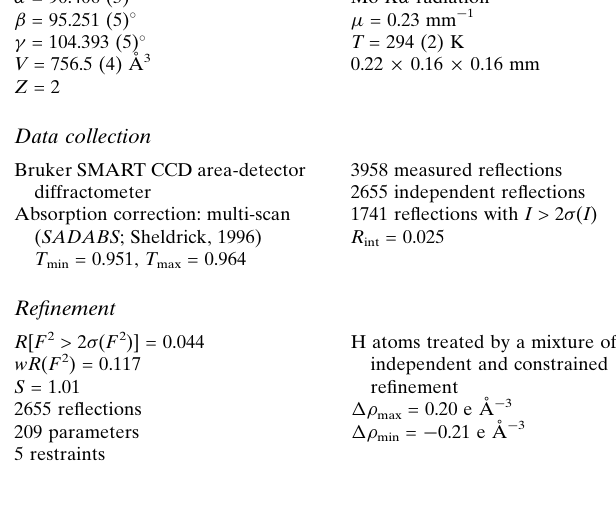
Hydrogen-bond geometry (A˚ , (cid:2) compound,